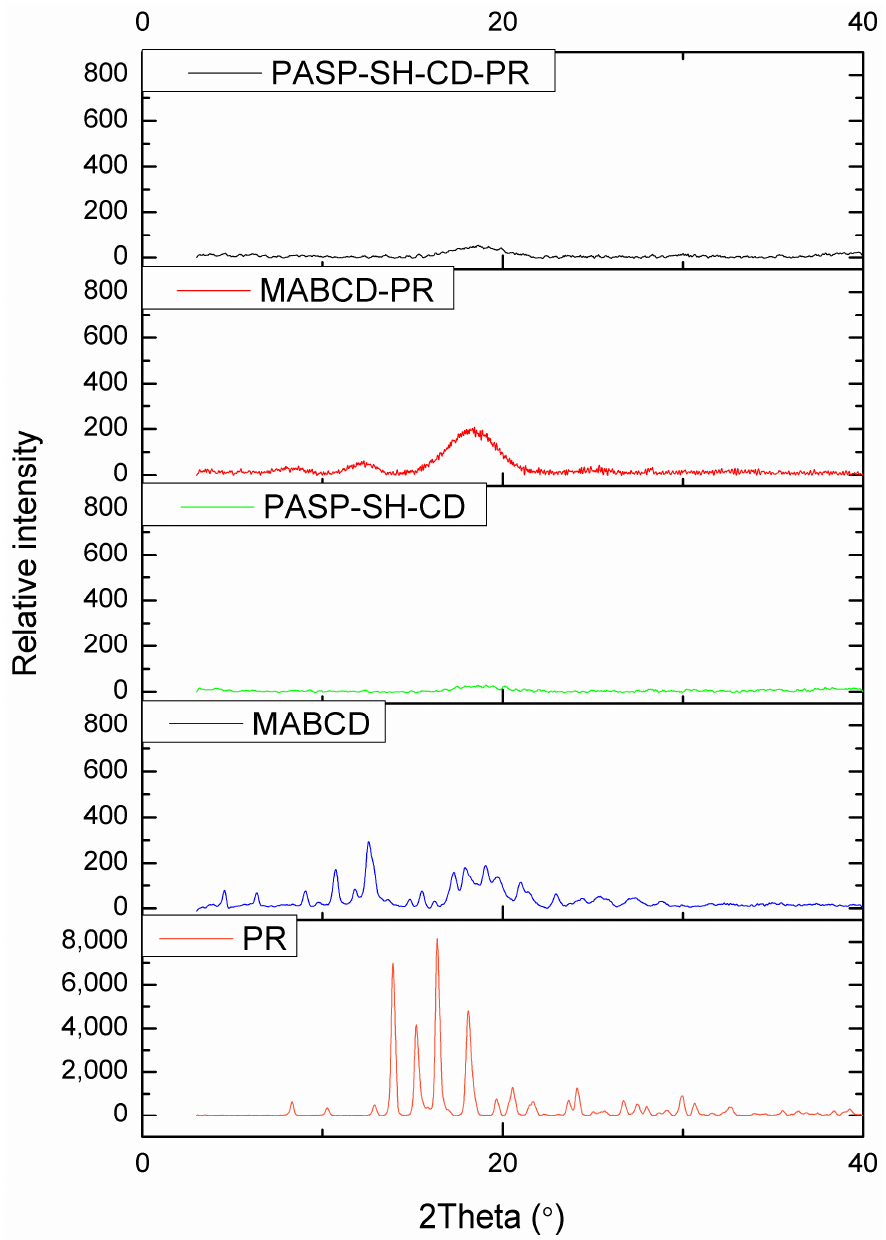
Figure 3. X-ray powder diffractogram of PR, MABCD, PASP-CEA-CD, and complexes of PR with MABCD and PASP-CEA-CD.